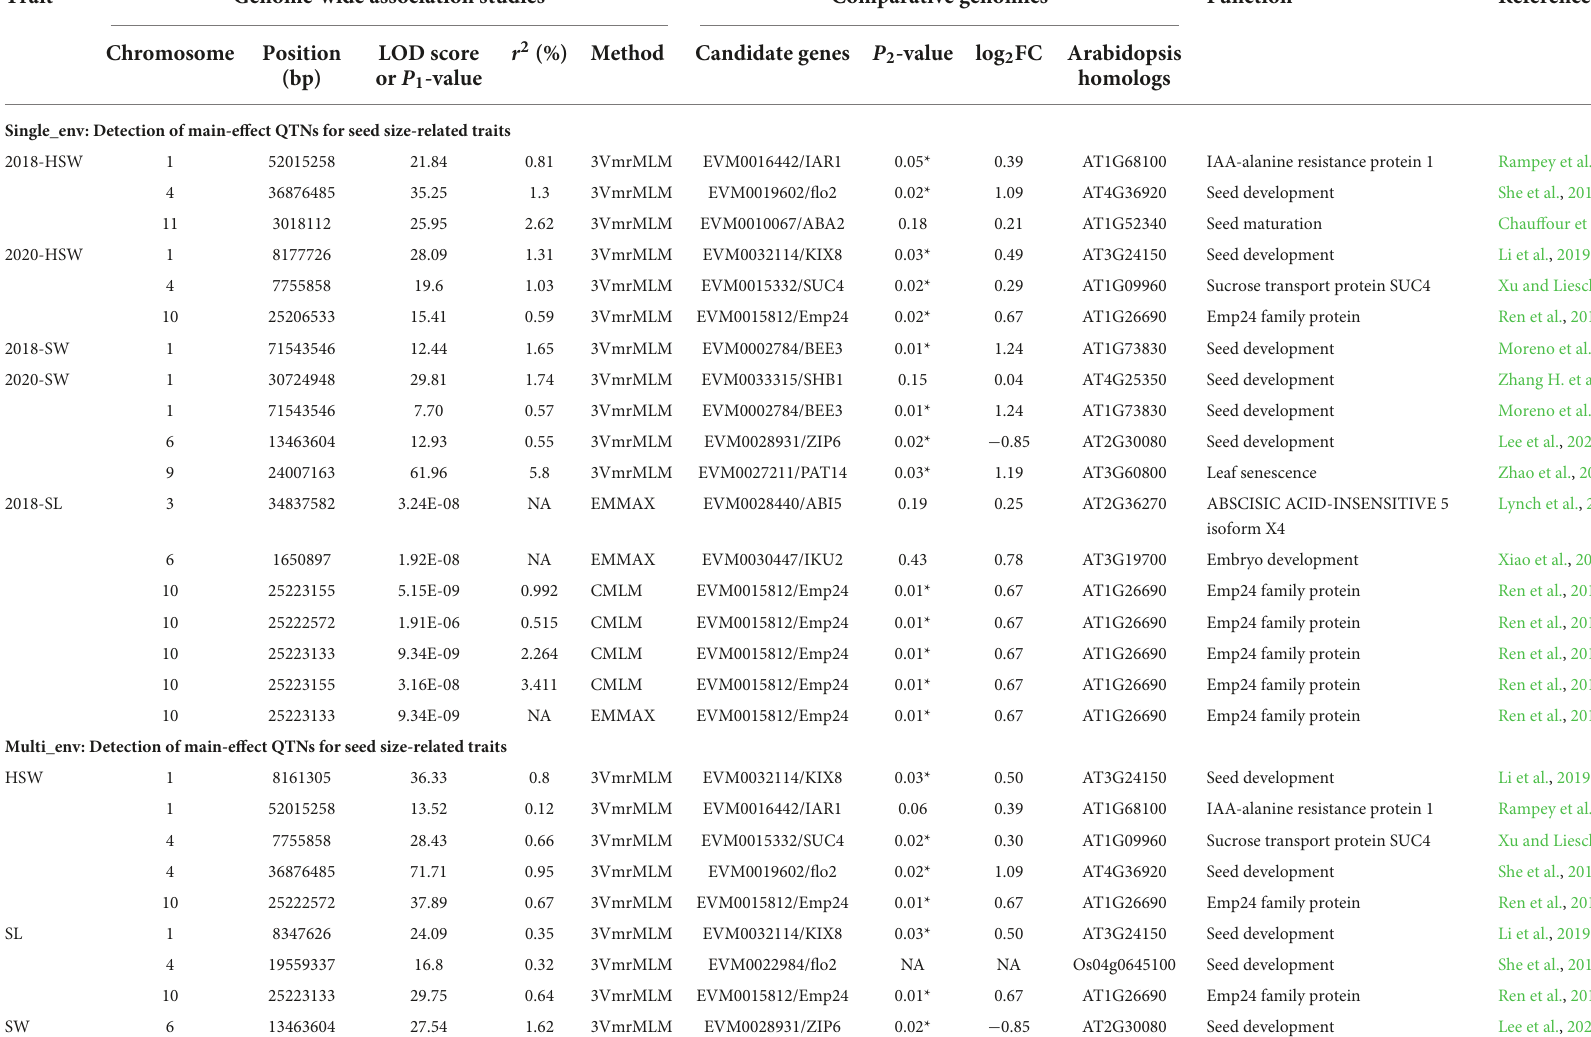
TABLE 1 Eight key candidate genes derived from genome-wide association studies for seed-related traits. Trait Genome-wide association